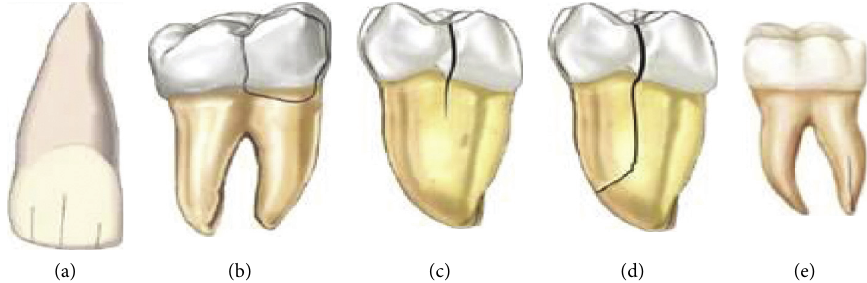
Figure 1: (a) Visible fracture lines within the enamel suggestive of craze lines; (b) fractured cusp terminating in the cervical part of the tooth; (c) cracked tooth extending from the occlusal tooth surface without separation of tooth fragments; (d) separated tooth fragments suggestive of a split tooth; and (e) vertical root fracture